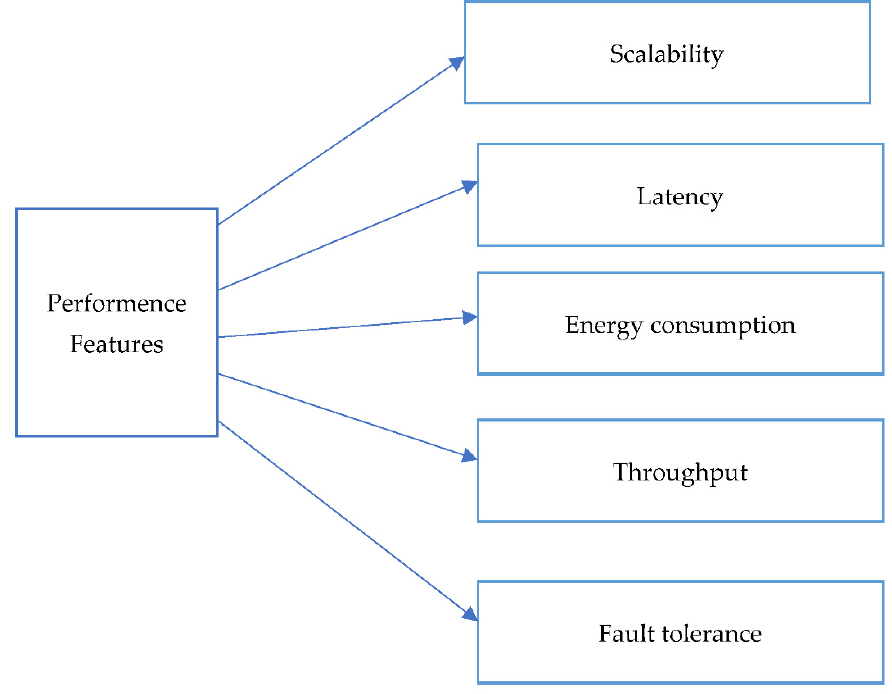
Figure 5. Types of feature properties.